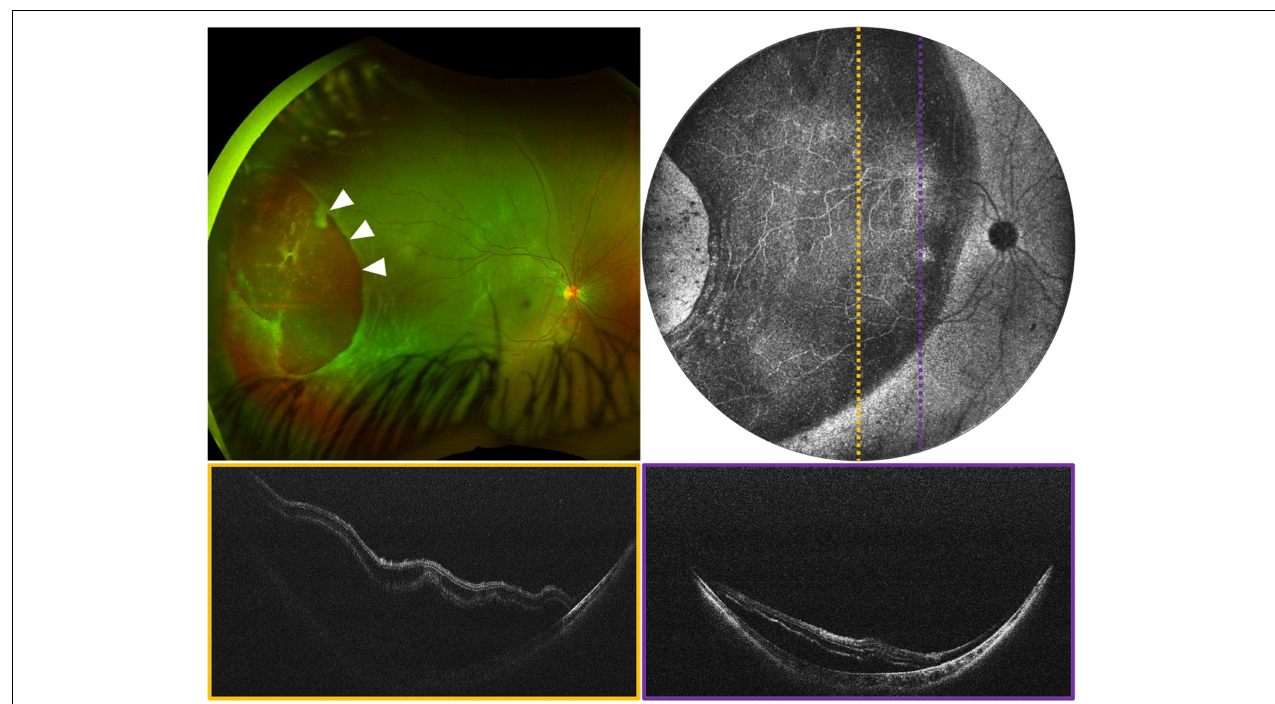
FIGURE 3 | Rhegmatogenous retinal detachment (RRD) in a 5-year-old girl, evaluated using widefield OCT. (Top left) Image is an ultra-widefield fundus photograph, with white arrows indicating a large temporal break. (Top right) Image is the 105 ◦ FOV OCT en face , with dotted lines indicating the locations of the color-coded B-scans shown